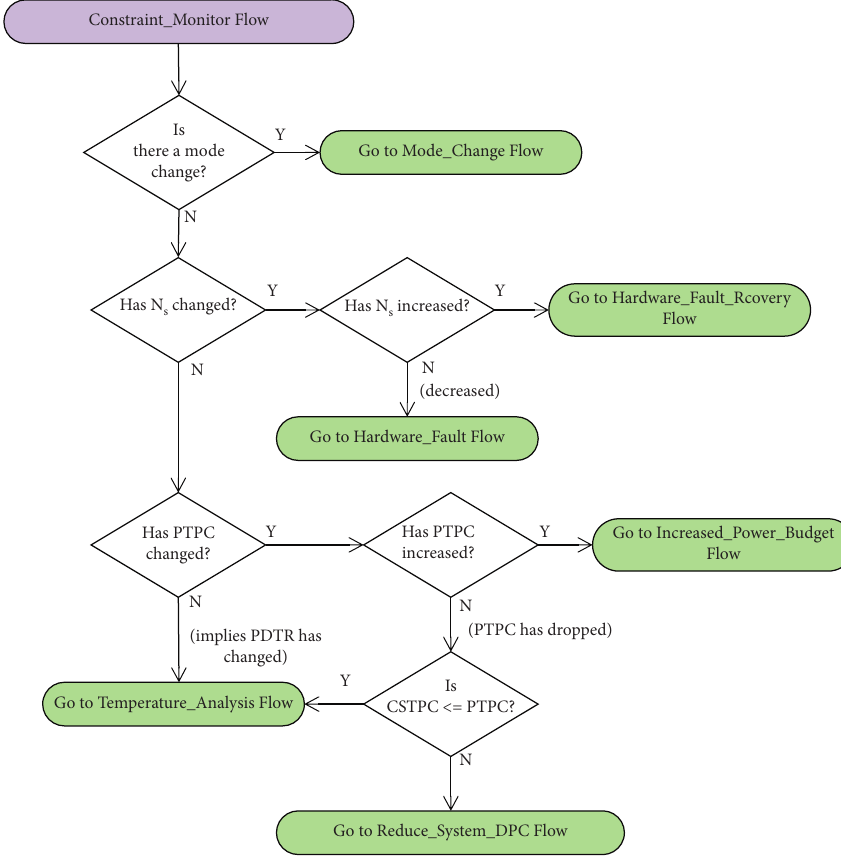
Figure 2: Constraint_Monitor flow of